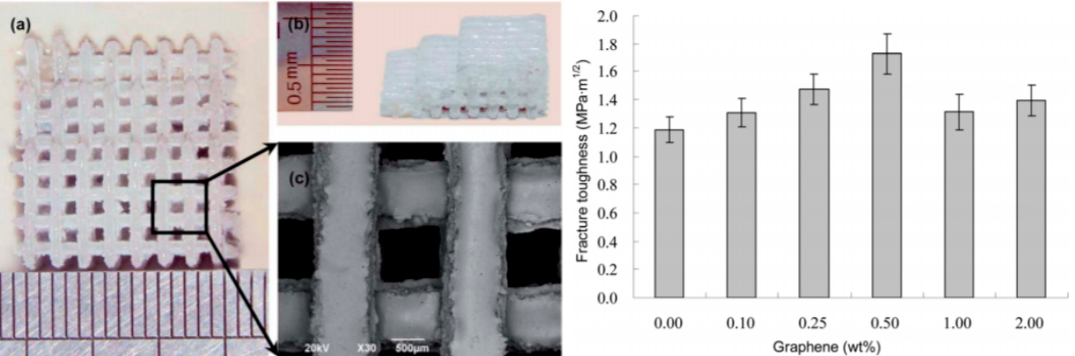
Figure 14. Images of Graphene-CaSiO 3 porous scaffold fabricated using SLS (left) and variation in fracture toughness on addition of G (right). There was an optimal level of G loading in terms of fracture toughness due to the inability to disperse the G within the matrix [275].